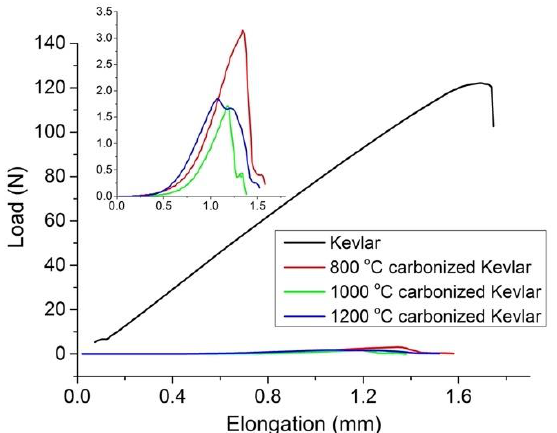
Figure 4. Load elongation curve for carbonized Kevlar fabrics.